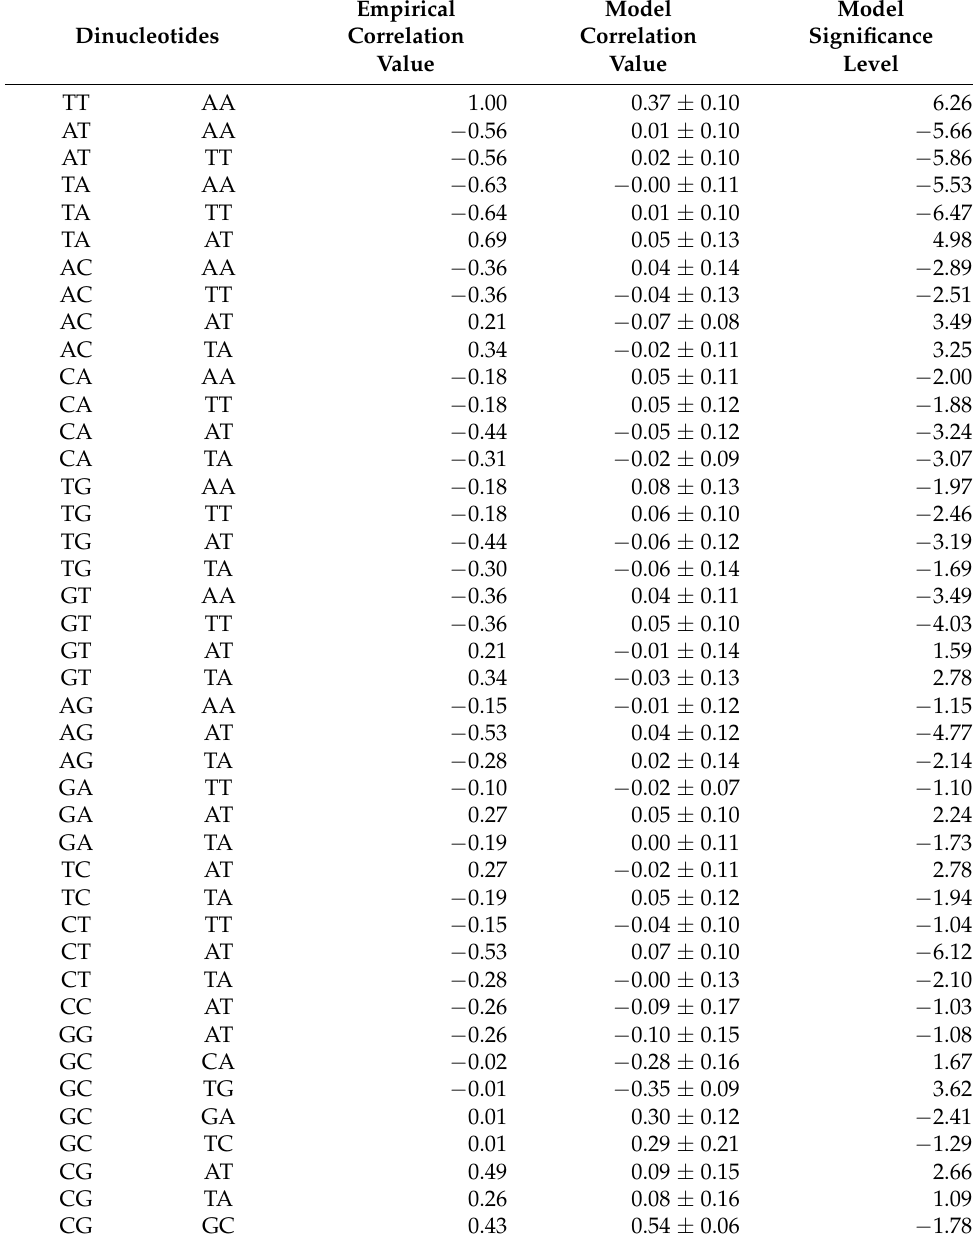
Table 2. Correlated dinucleotide pairs not explained by genes, CDS or chromosome length corre- lations. Significantly correlated dinucleotide pairs (see Table S2). Pairs with correlations expected by a shared significant correlation of both dinucleotides with genes, CDS or chromosome length were